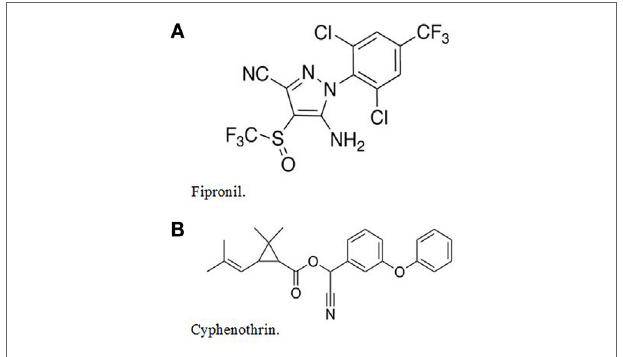
FigUre 1 | The chemical structures of (a) fipronil and (B) cyphenothrin